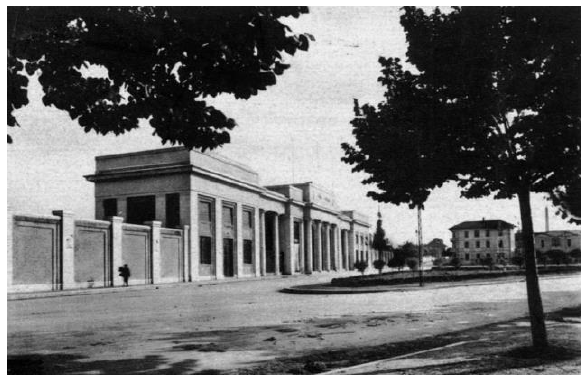
Figure 3. Foro Boario. http://www.spaziindecisi.it/new/wp-